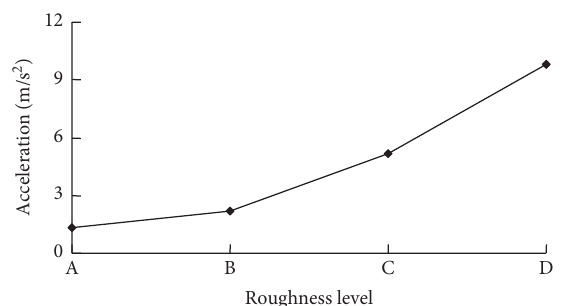
Figure 11: The variation curve of peak values of vertical vibration accelerations of the vehicle body.